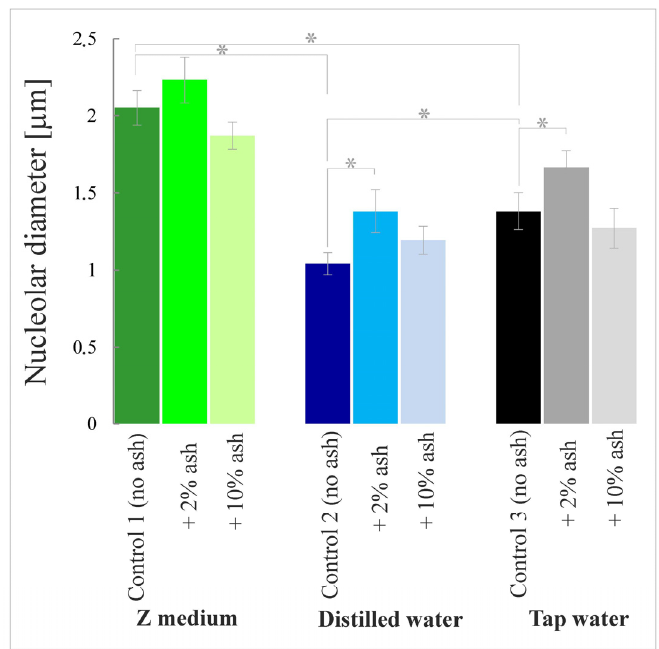
Figure 4. Sizes (diameters) of nucleoli in meristematic cells of S. polyrrhiza root tips grown in respective media; asterisks show statistically significant differences between particular root lengths at p < 0.05; bars represent standard deviations (average sizes ± SD).